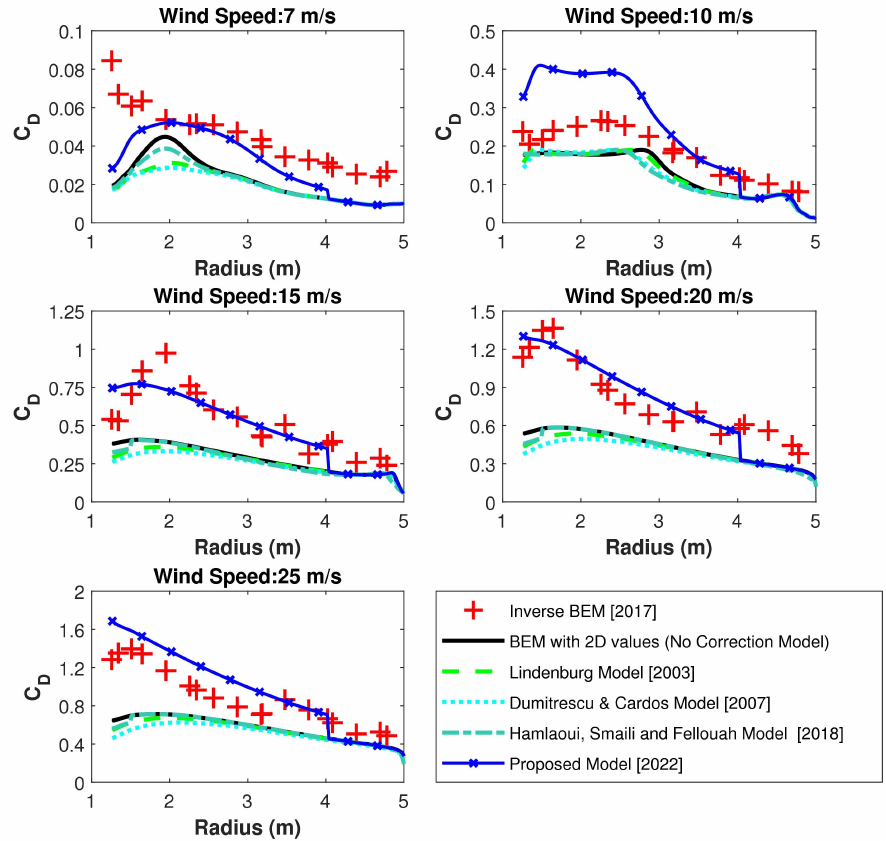
Figure 12. Contrast of evaluated C D throughout the blade length from BEM analysis without and with different correction models for stall delay and Inverse BEM method for NREL Phase VI turbine.